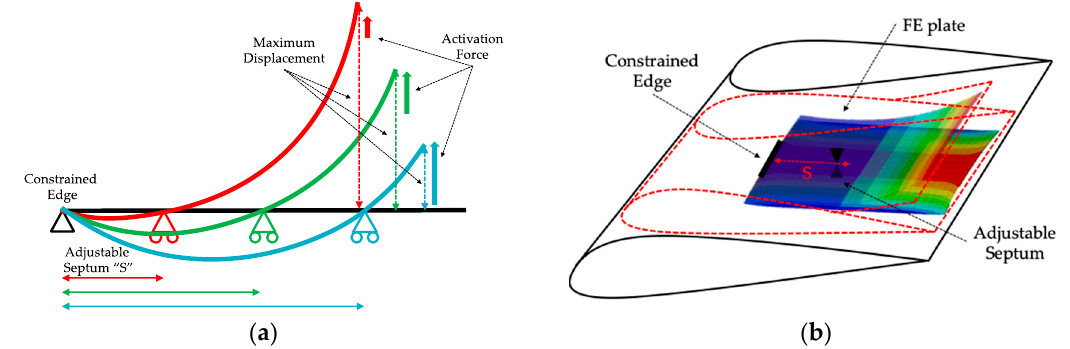
Figure 5. ( a ) Lever effect graphic and ( b ) finite element (FE) model (two stable states) on a UAV stabilizer.